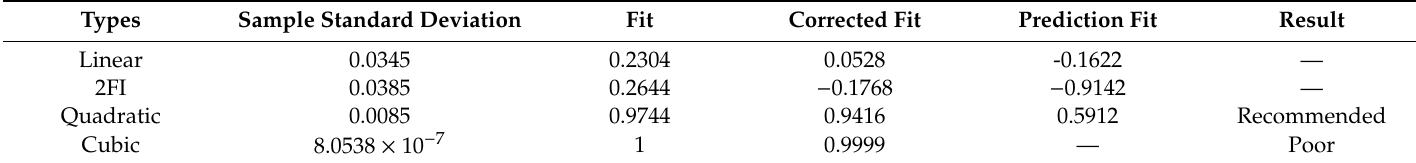
Table 13. Model summary